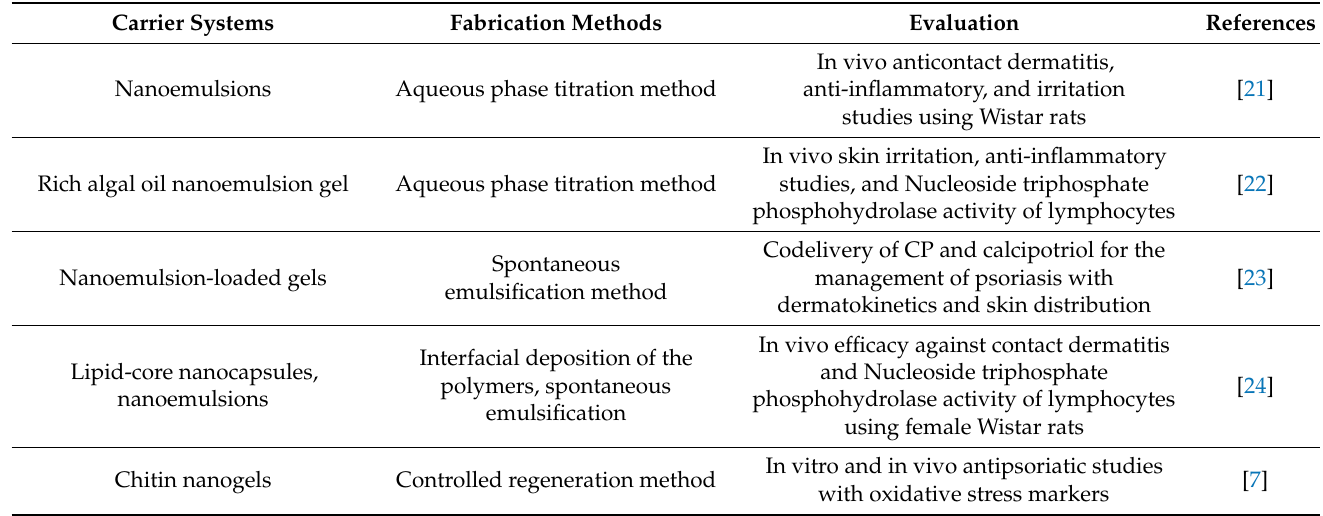
Table 1. Novel formulations reported for clobetasol propionate since